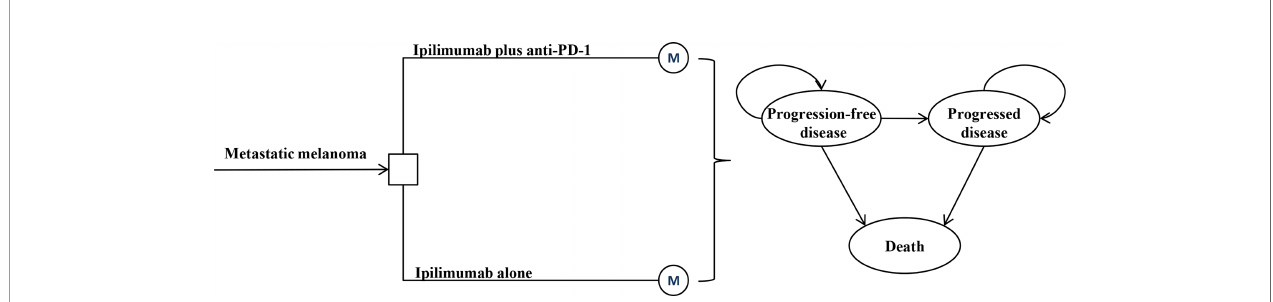
FIGURE 1 | Model structure for metastatic melanoma resistant to anti-PD-(L)1